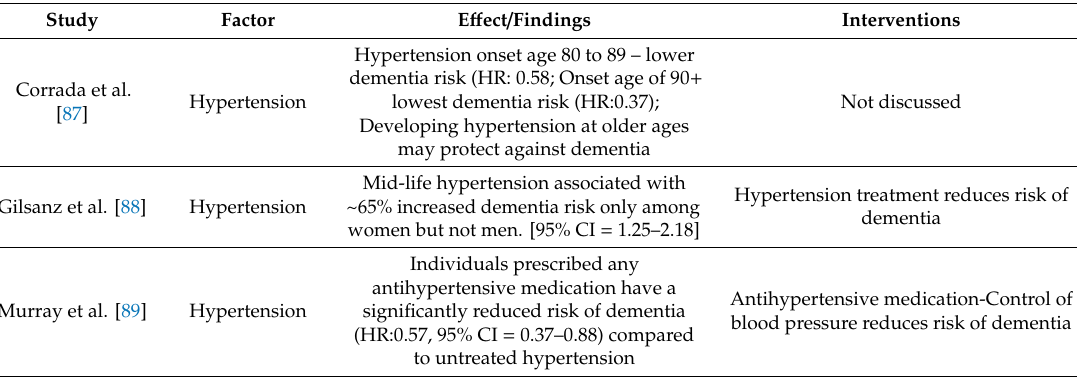
Table 3. Association of the obesity, diabetes mellitus and hypertension with the risk for development of dementia / Alzheimer’s